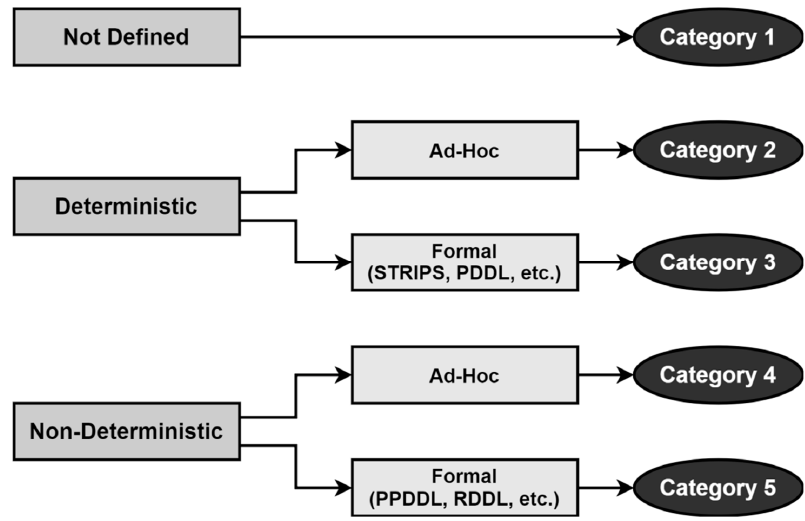
Figure 2. Mission plan specification assessment diagram (1st group). Table 1. Mission plan specification assessment (1st group).